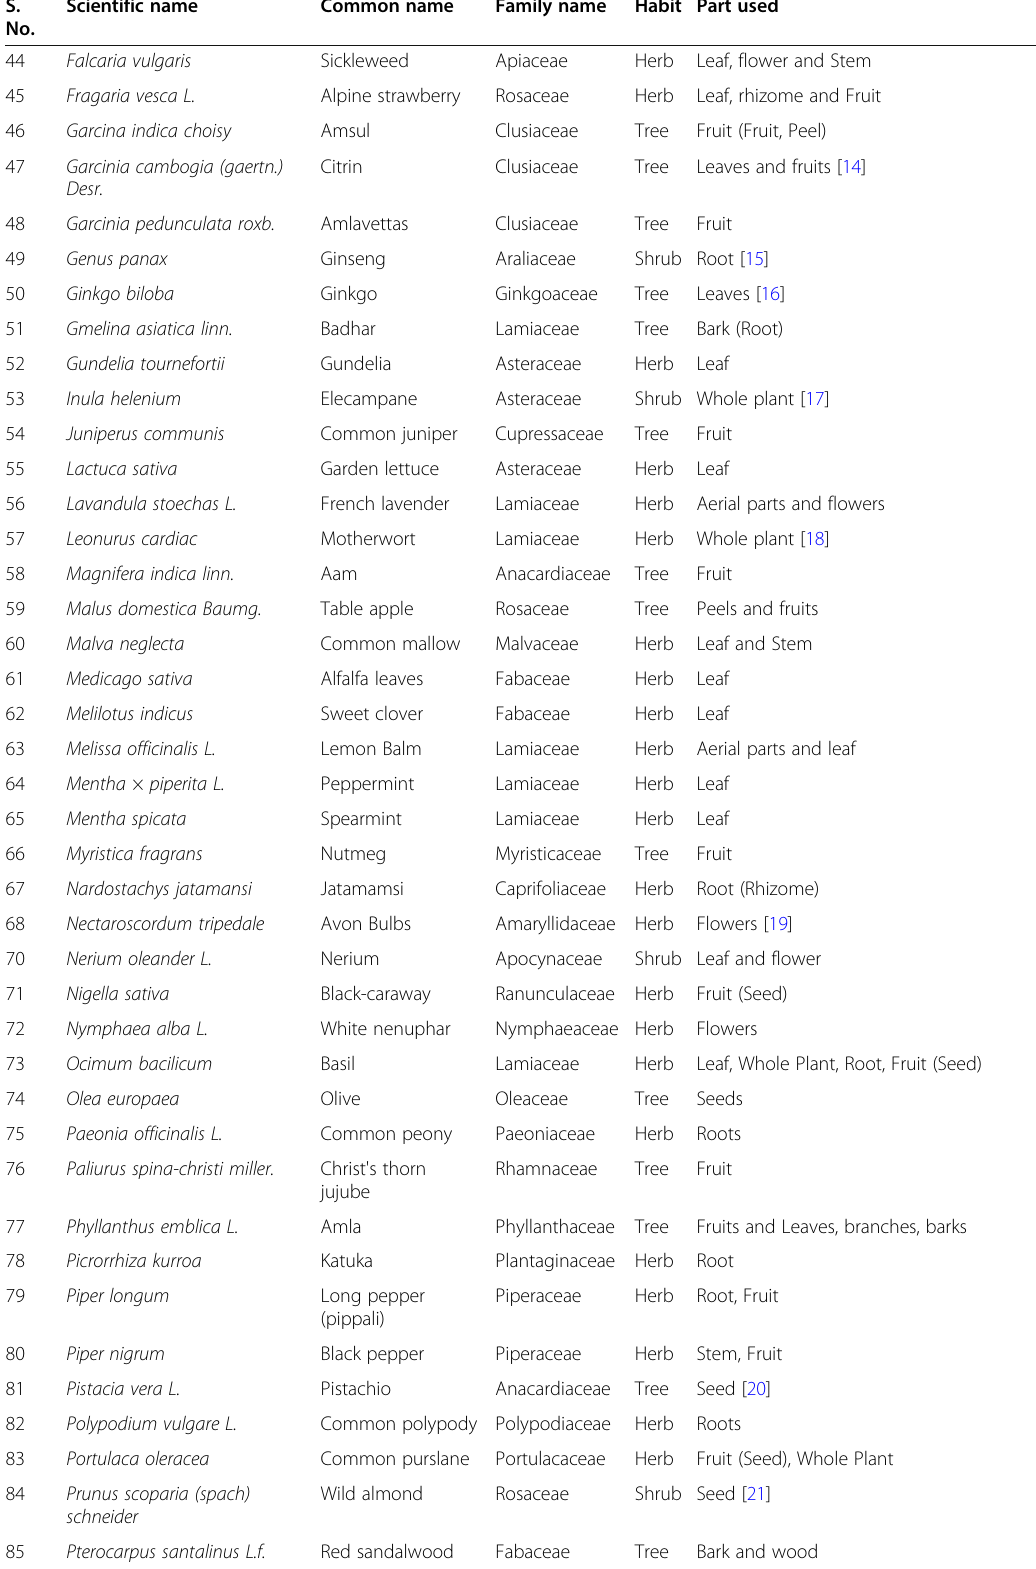
Table 1 List of plants, its habit and parts used for treatment of heart disease (Continued) S.